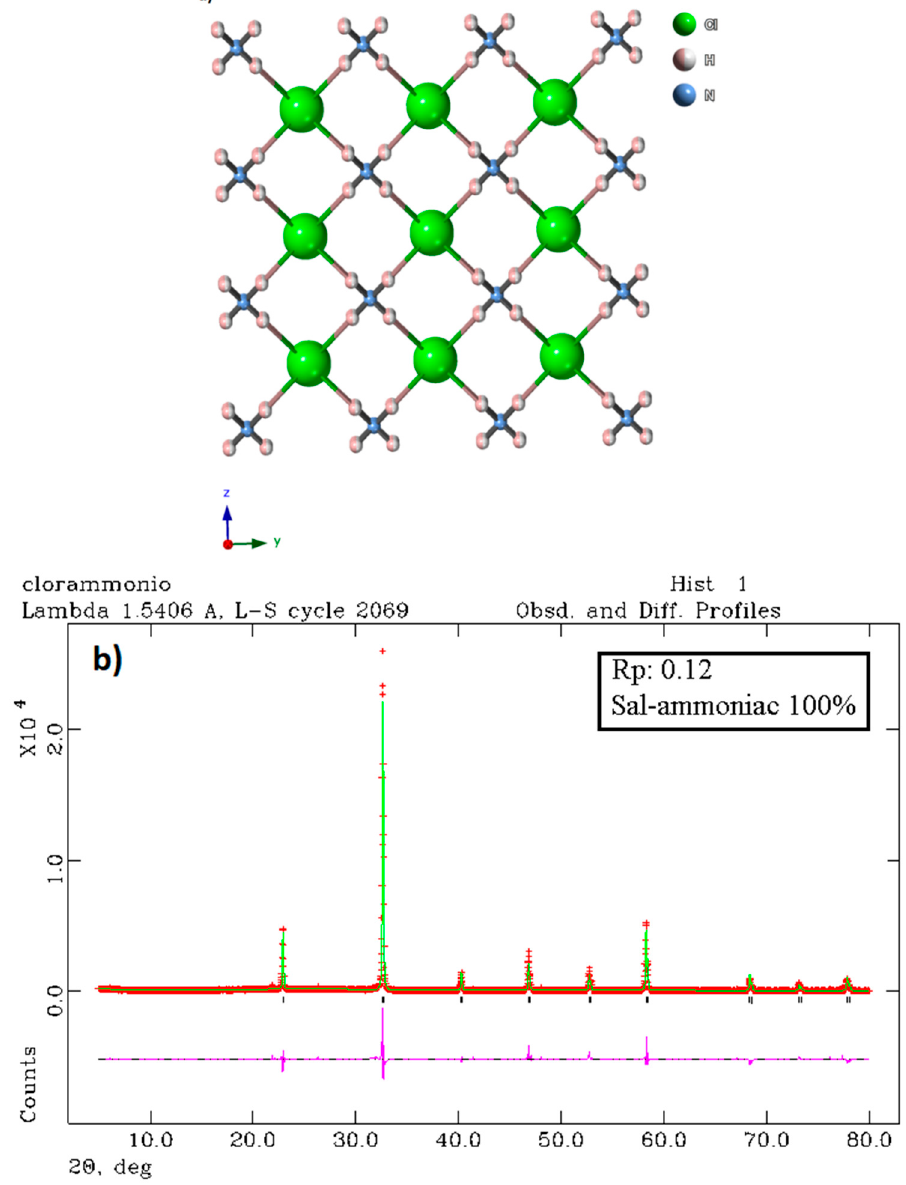
Figure 9. ( a ) Crystal structure of sal-ammoniac projected along the x axis. Cl atoms in green, N atoms in blue, H atoms in white–pink. The blue sticks indicate the N-H bonds and the pink–green sticks the NH…Cl hydrogen bonds. ( b ) The X-ray diffraction spectrum of the sample indicated as sal-ammoniac refined with the Rietveld method [50], using GSAS EXPGUI [51,52] software. At high temperature in the range 455–463 K on heating and 453–433 K on cooling, sal-ammoniac undergoes another phase transition from CsCl to NaCl structure type